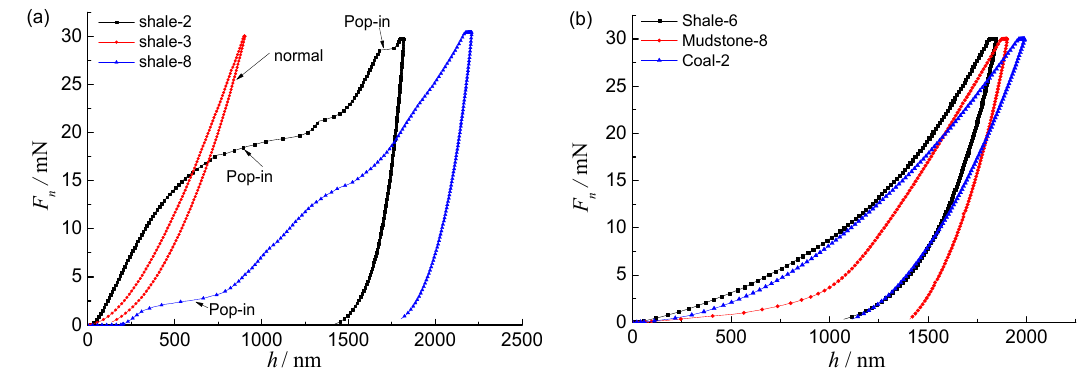
Figure 6. ( a ) Distinction and ( b ) similarity of load-depth curves.